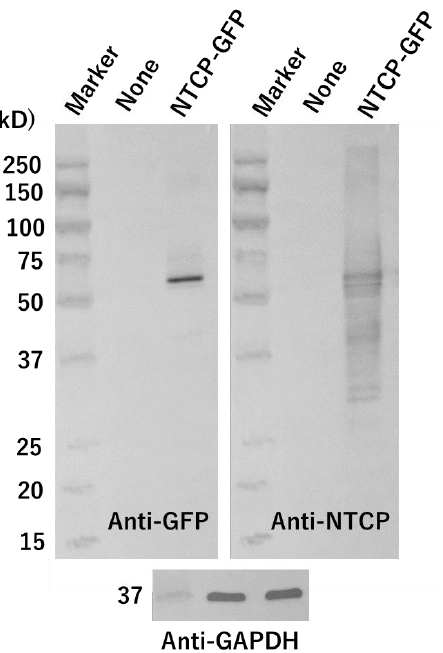
Figure 2. Western blot analysis of HEK293T cells transiently expressing NTCP-GFP. HEK293T cells transfected with (lanes indicated as NTCP-GFP) or without (those indicated as None) an NTCP-GFP expression plasmid were cultured for 24 h and then lysates were prepared from them. Cell lysates were subjected to SDS-PAGE at 2 µ g of protein/lane under reducing conditions. The same membrane, to which electrophoresed proteins were transferred, was repeatedly used for the detection of target proteins by the indicated antibodies after an antibody bound to the filter was detached using a stripping solution.